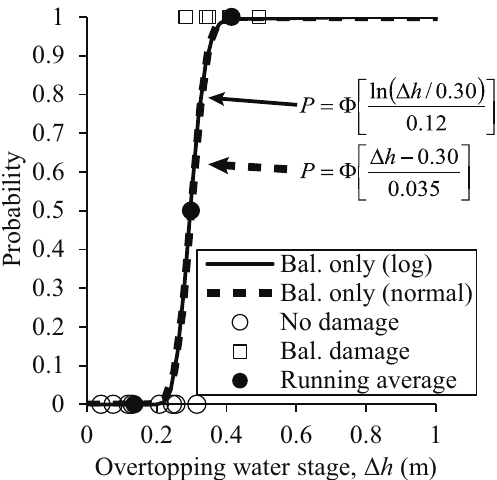
Figure 10. Fragility curves for embankment scour damage de- scribed by normal and log-normal distributions. Figure 11. Fragility curves for ballast scour damage described by normal and log-normal distributions.